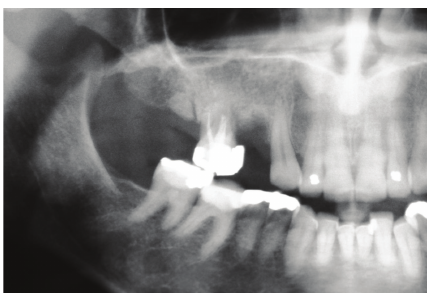
Figure 2: Radiograph shows hopeless upper molar with retained roots both mesial and distal to the tooth.